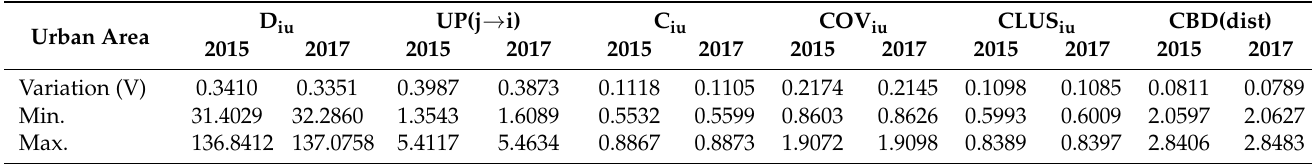
Table 4. Descriptive statistics values of morphological indicators for 2015 and 2017.